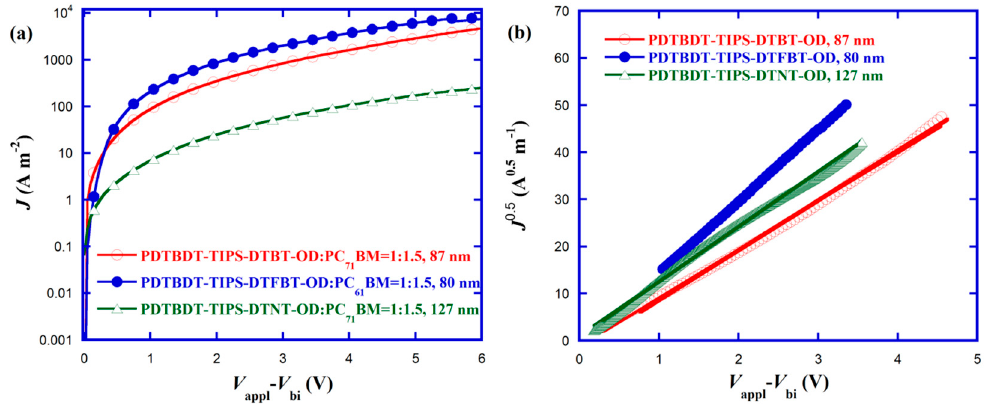
Figure 8. J – V ( a ) and J 1/2 – V ( b ) characteristics of the hole-only